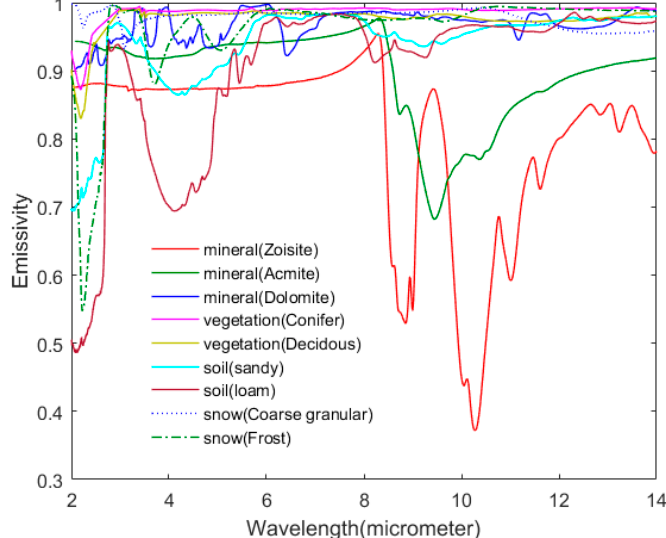
Figure 2. Spectral emissivity of nine samples of materials derived from the MODIS UCSB (University of California, Santa Barbara) emissivity library [34] and the Advanced Spaceborne Thermal Emission and Reflection Radiometer Spectral Library Version 2.0